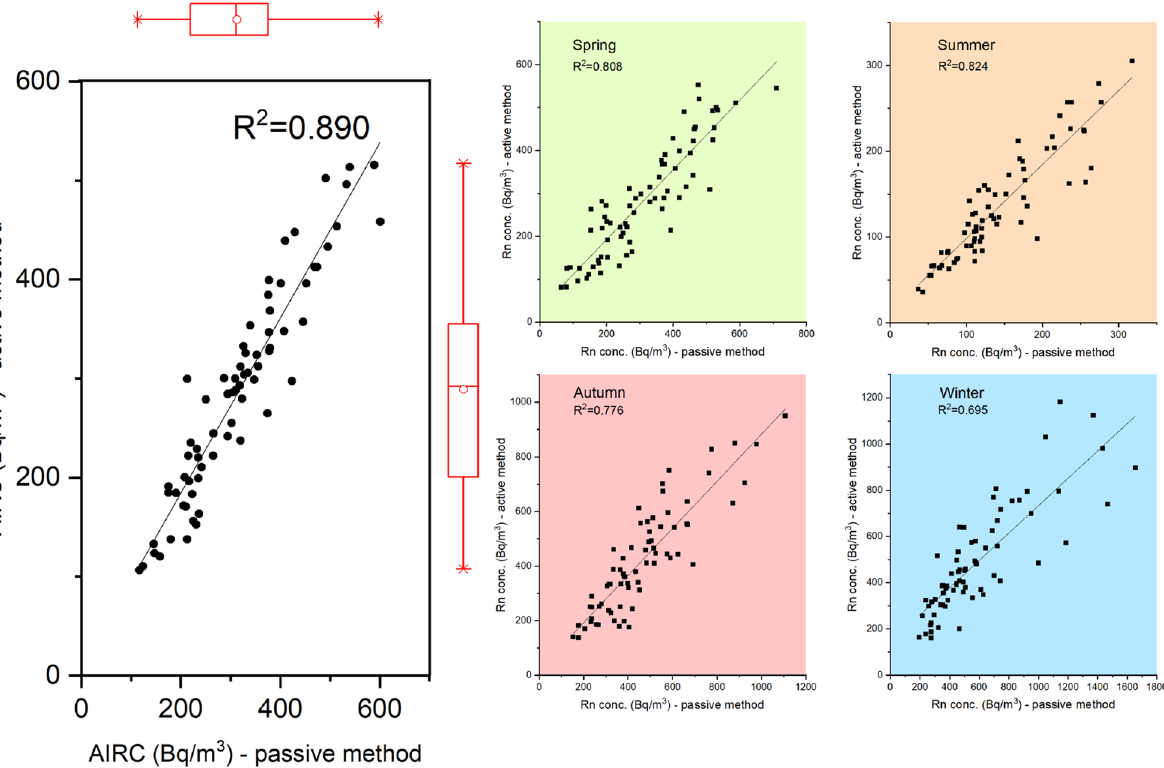
Figure 1. Scatterplots between passive and active methods (left side); the figure also shows the box-plots of data distribution. The same analysis is shown according to the measurement periods (right side). The figure was made using OriginPro 2019b software (www. origi nlab.